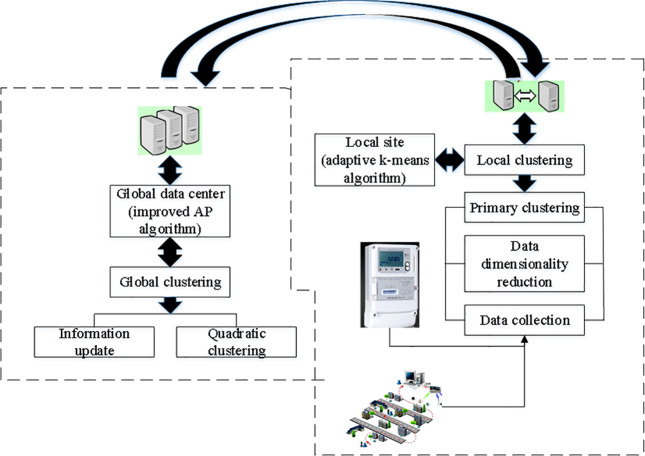
Two-layer framework based on DCA.